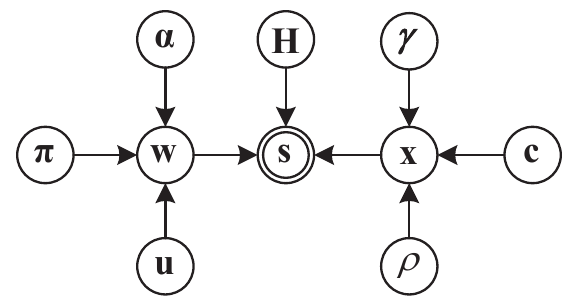
Figure 2. Probabilistic graphical